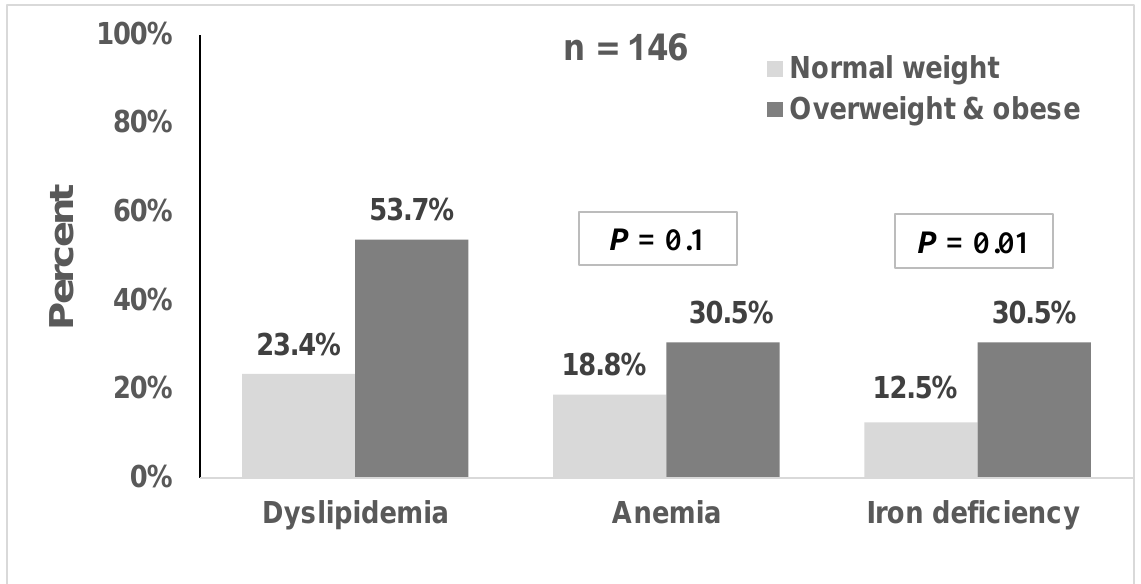
Figure 1. Distribution of dyslipidemia, anemia, and iron deficiency by obesity .